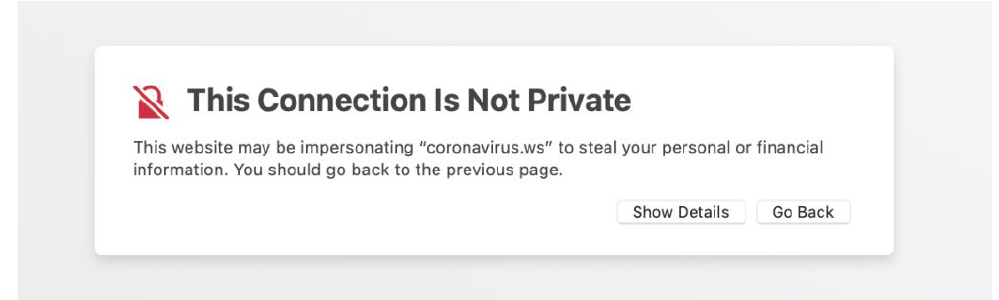
Figure 3. Browser warning when attempting to reach